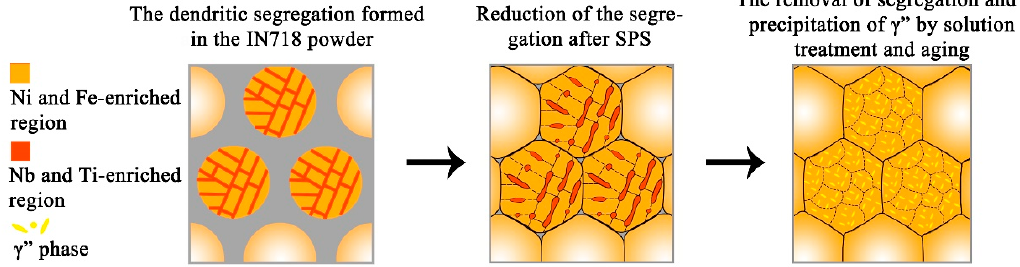
Figure 11. Schematic illustration of the microstructural evolution of SPS IN718 alloy during sintering and heat treatment.